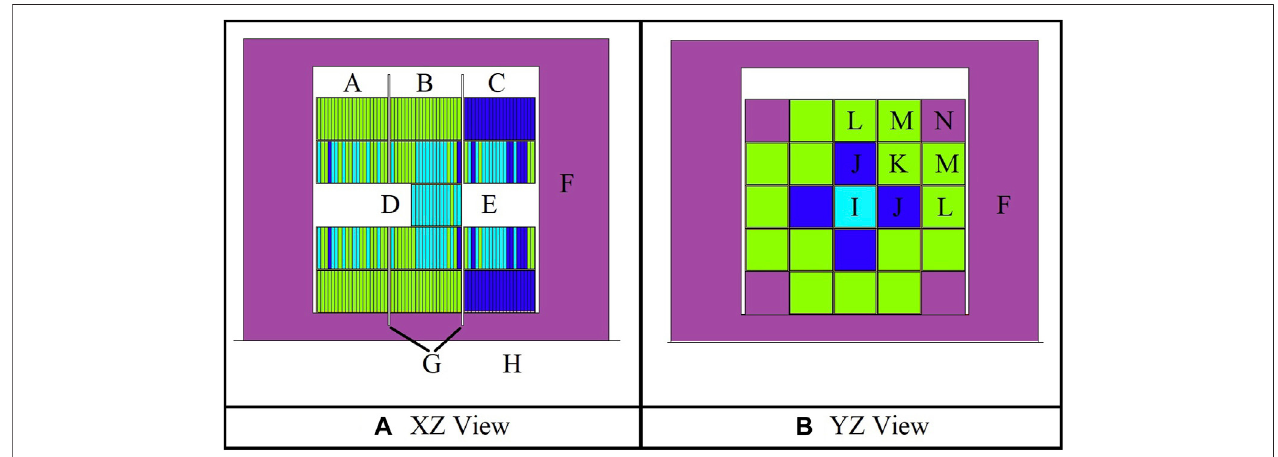
FIGURE 2 | Fast Neutron Source MCNP Geometry (A) XZ and (B) YZ